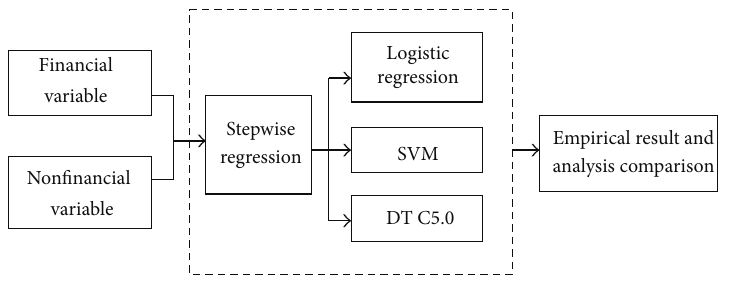
Figure 2: Research